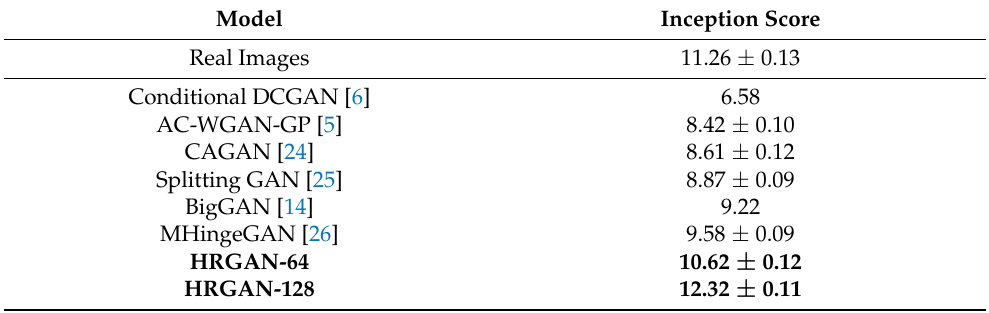
Table 3. The Inception scores of CIFAR10 dataset. The bold indicates the proposed HRGANs.